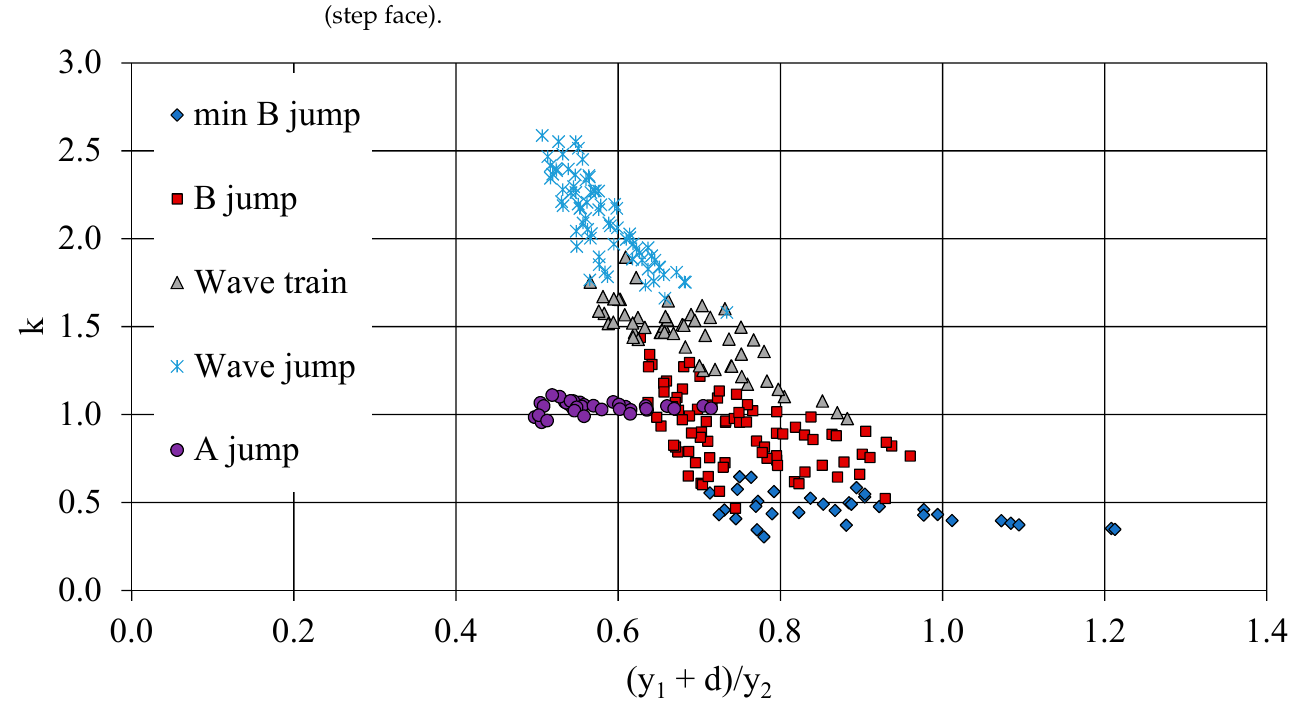
Figure 7. Correction coefficient k to balance the momentum equation versus (y 1 + d)/y 2